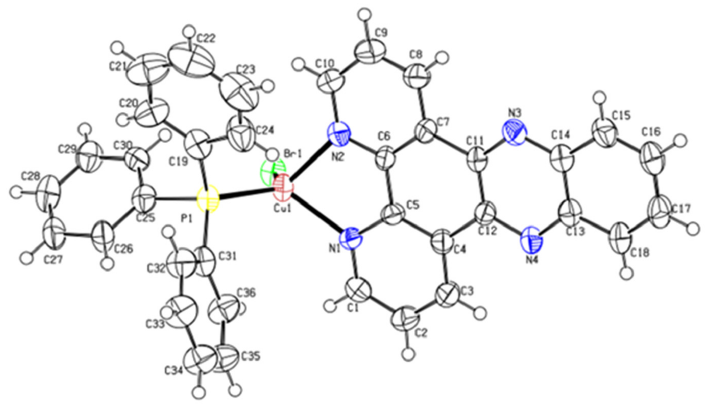
Figure 3. ORTEP diagram of Cu-1 with thermal ellipsoids drawn at the 50% probability level.